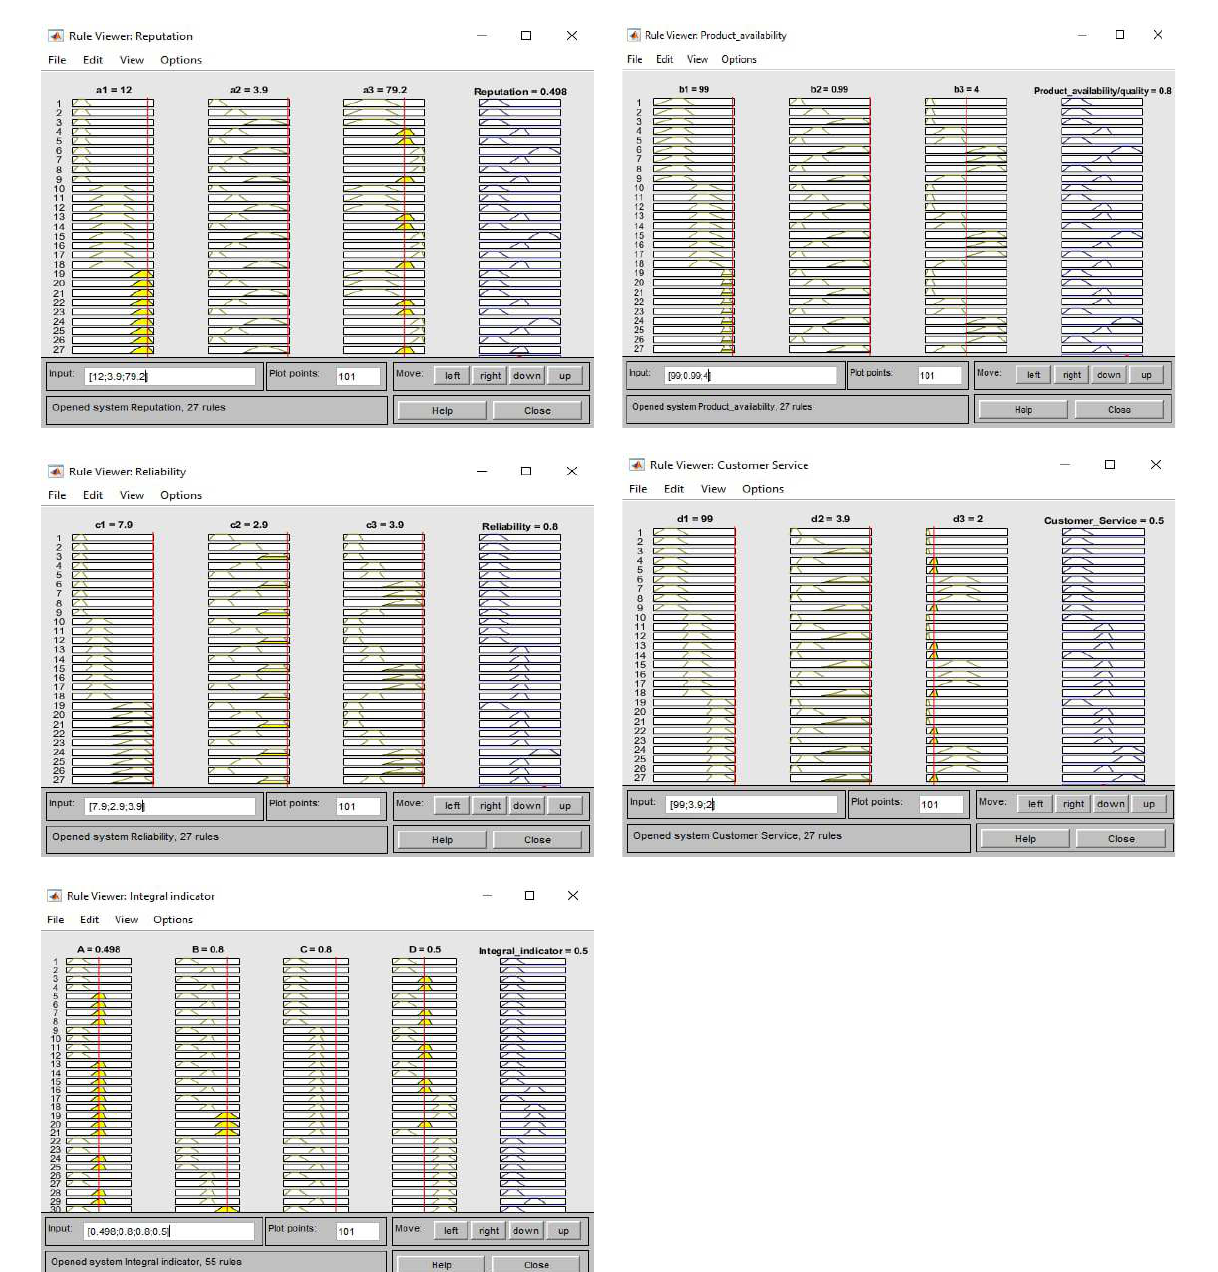
Figure A2. Realized defuzzification of data to the final level of the developed fuzzy model – an integral indicator of the quality of logistics service for Company No.